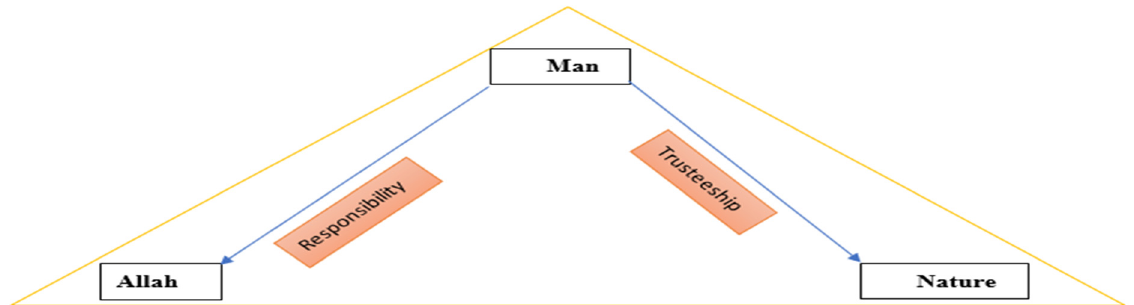
Figure 1. Relationship between Allah, nature and human beings, Source: authors’ drawing.